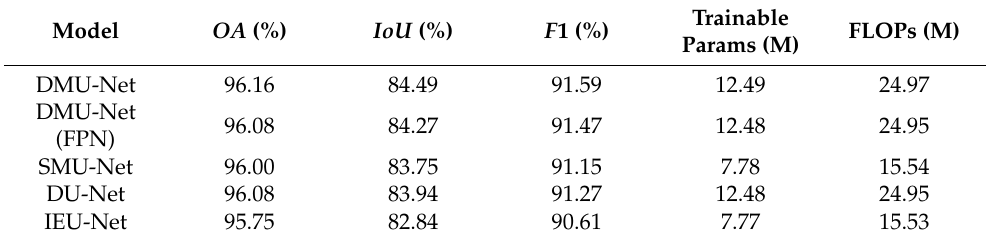
Table 5. The accuracy of building extraction of different network structures.